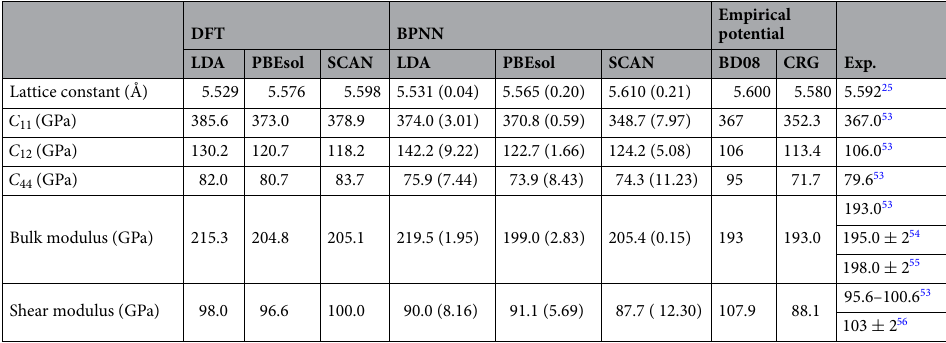
Table 2. Lattice constant and elastic properties of ThO 2 obtained by DFTs, BPNNs, emprical potentials, and experiments (Exp.). The round brackets ( · ) in the BPNN columns represent the percentage errors of the BPNN results against the DFT results.